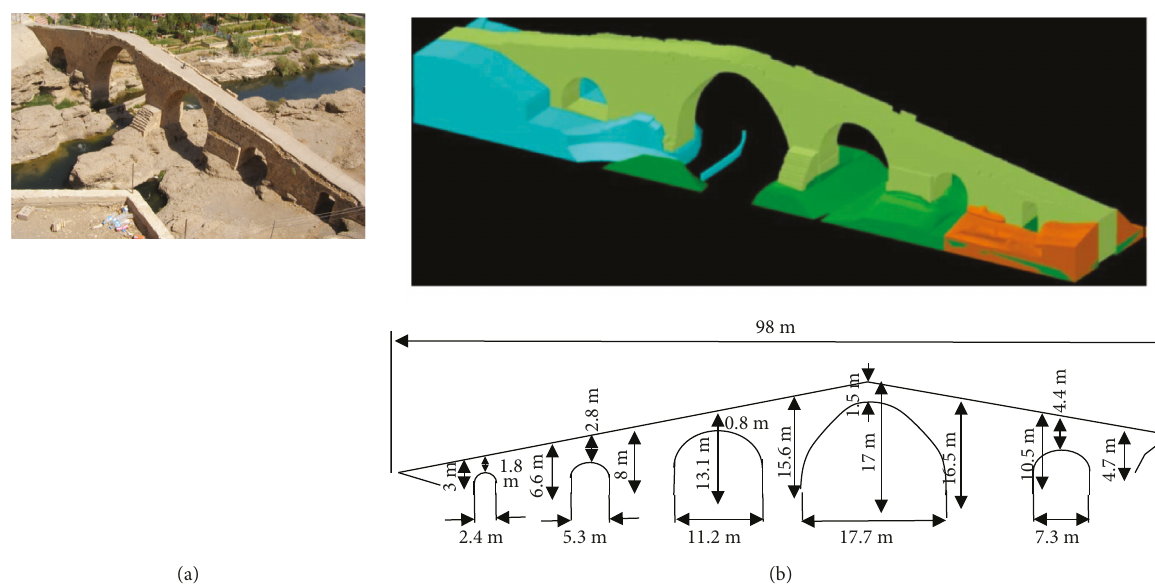
Figure 1: (a) Photogrammetric view. (b) 3D model of Dalal Bridge in 3D Studio Max, and the dimensions of Dalal Bridge in Zakho city